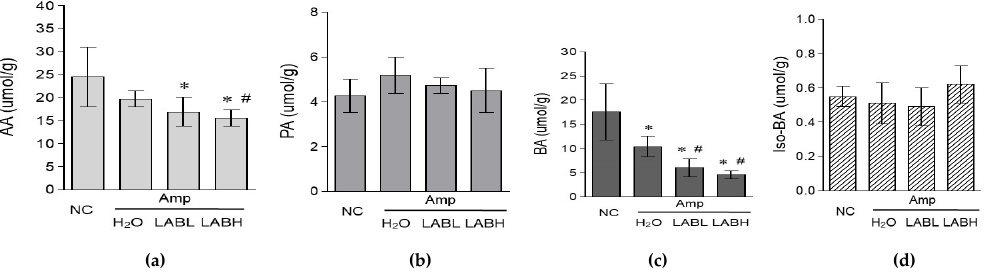
Figure 6. Effect of Lactobacillus spp. on short-chain fatty acid levels in C57BL/6J mice. C57BL/6J mice ( n = 6/group) were grouped into the NC and Amp groups. The groups given the three-strain combination were fed a dose of 1.6 × 10 8 CFU/mouse (LABL) or 4.8 × 10 8 CFU/mouse (LABH) from the 3rd day until the 7th day. All groups were analyzed for short fatty acid levels in cecal content samples on the 12th day. Each SCFA standard compound was used for quantitative analysis. The levels of each SCFA were provided in units of “ µ mol/g cecum content”. Then, the levels were presented as “the percentage of individual SCFA/total SCFA.” ( a ) Relative levels of retinoic acid, ( b ) butyric acid, ( c ) acetic acid, and ( d ) isobutyric acid. *, compared with NC group, p < 0.05; #, compared with Amp group, p < 0.05.